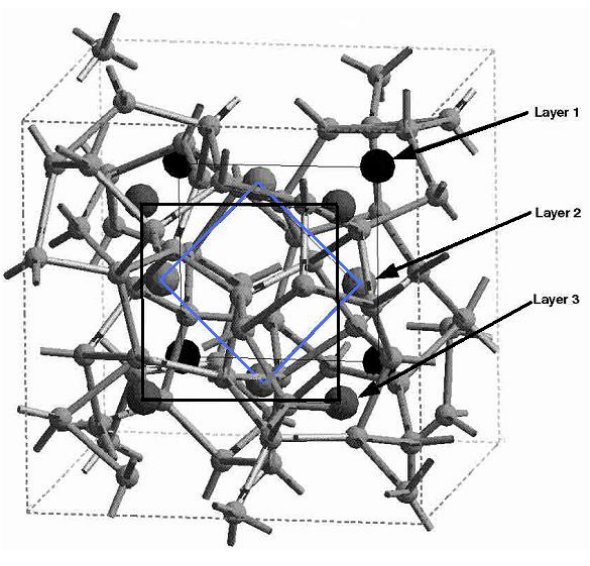
Figure 7. The initial location of the 12 hydrogen atoms (darker, larger balls) within the amorphous cell of pure silicon is shown. See Table 1 in Section